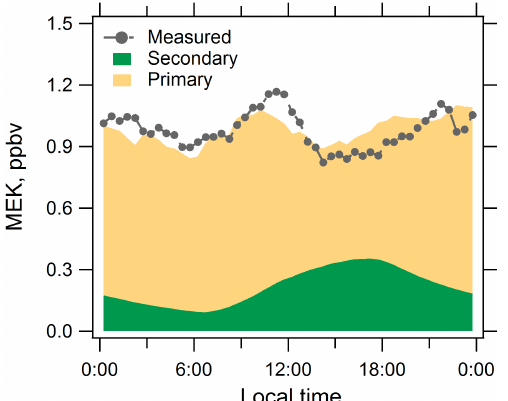
Figure 7. Partitioning of MEK to primary emissions (yellow area) and secondary chemical formation (green area) at the PKU site, and the dashed black lines with solid dots represent measured concen-